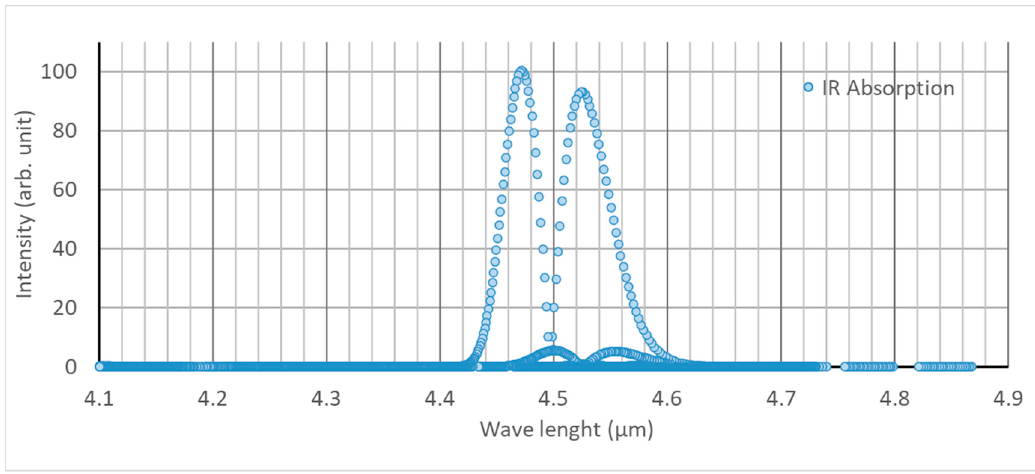
Figure 2. Graph of the IR absorption bands for N 2 O gas based on the data from HITRAN